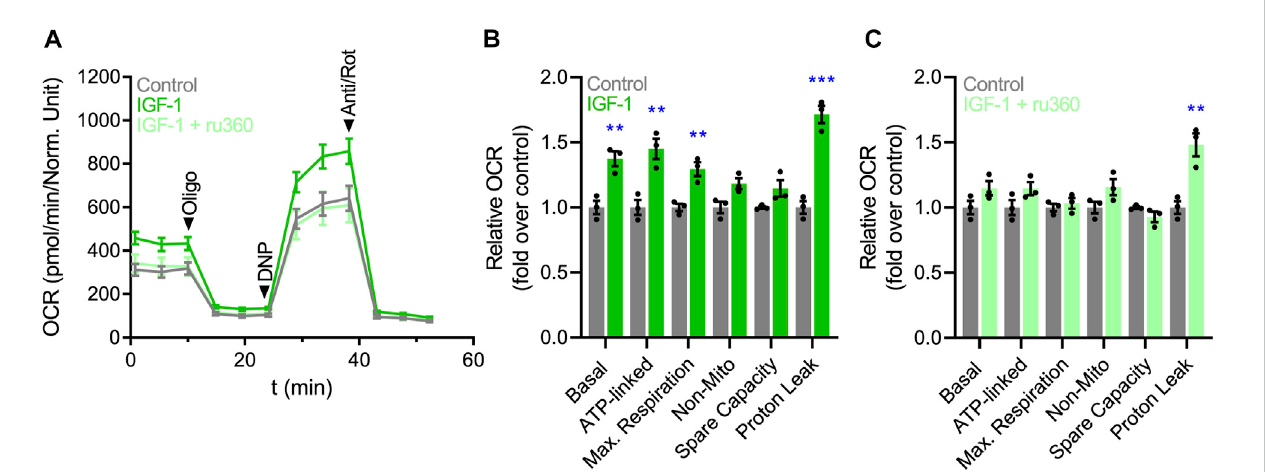
FIGURE 3 IGF-1 increases mitochondrial respiration by a mechanism dependent on mitochondrial Ca 2+ uptake. (A) Representative plot of OCR over time. (B) Quanti fi cation of the relative changes in OCR (basal respiration, ATP-linked respiration, maximal respiration, non-mitochondrial respiration, spare capacity, and proton leak) in hES-CMs stimulated with IGF-1 (10 nM for 24 h) or vehicle. (C) Quanti fi cation of the relative changes in OCR in hES-CMs stimulated with ru360 (10 µM) or vehicle respiration ( n =